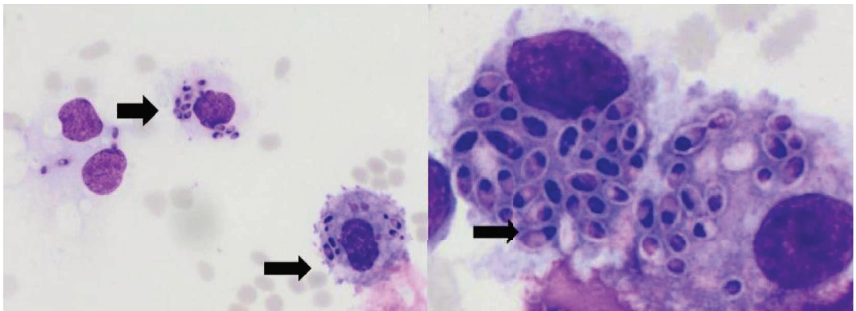
Figure 6: Bone marrow aspiration at the time of diagnosis showed Histoplasma capsulatum yeasts inside the